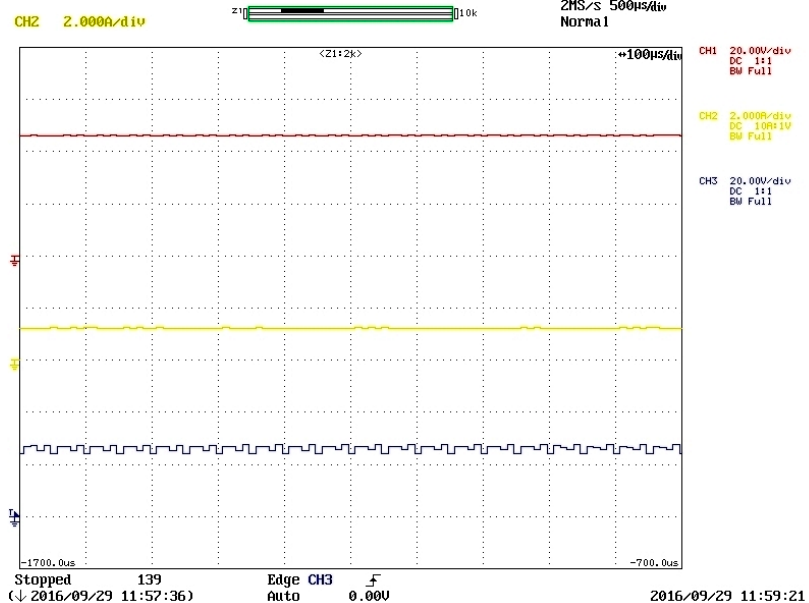
Figure 21. Results (for 09:00 A.M.) obtained by hardware implementation: CH1 : voltage across the load resistance (44.8 V); CH2 : current across the load (1.25 A); and CH3 : solar PV array’s terminal voltage ( V PV = 31.5 V).